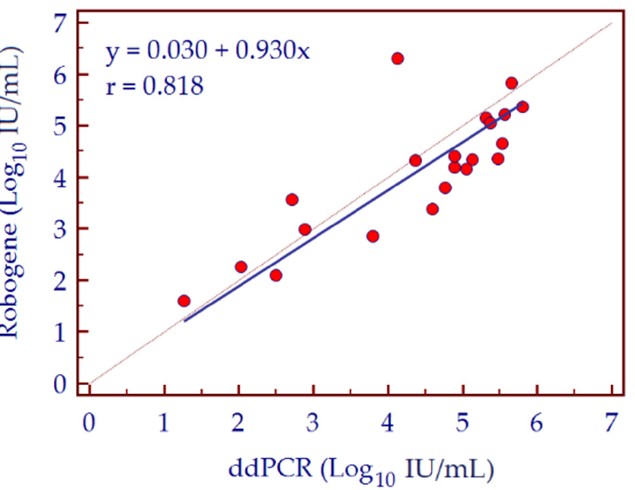
Figure 7. Bland-Altman plot comparing HDV-RNA values quantified by RT-qPCR and ddPCR assays. In the scatter diagram, the means of any two measurements shown in the x axis are plotted against the difference between those two measurements reported in the y axis. The blue horizontal line shows the mean of the differences and red horizontal dashed lines represent the 95% limits of agreement defined as the mean difference +1.96 SD of differences (1.04 and − 1.14). Abbreviations: hepatitis D virus (HDV); standard deviation (SD).